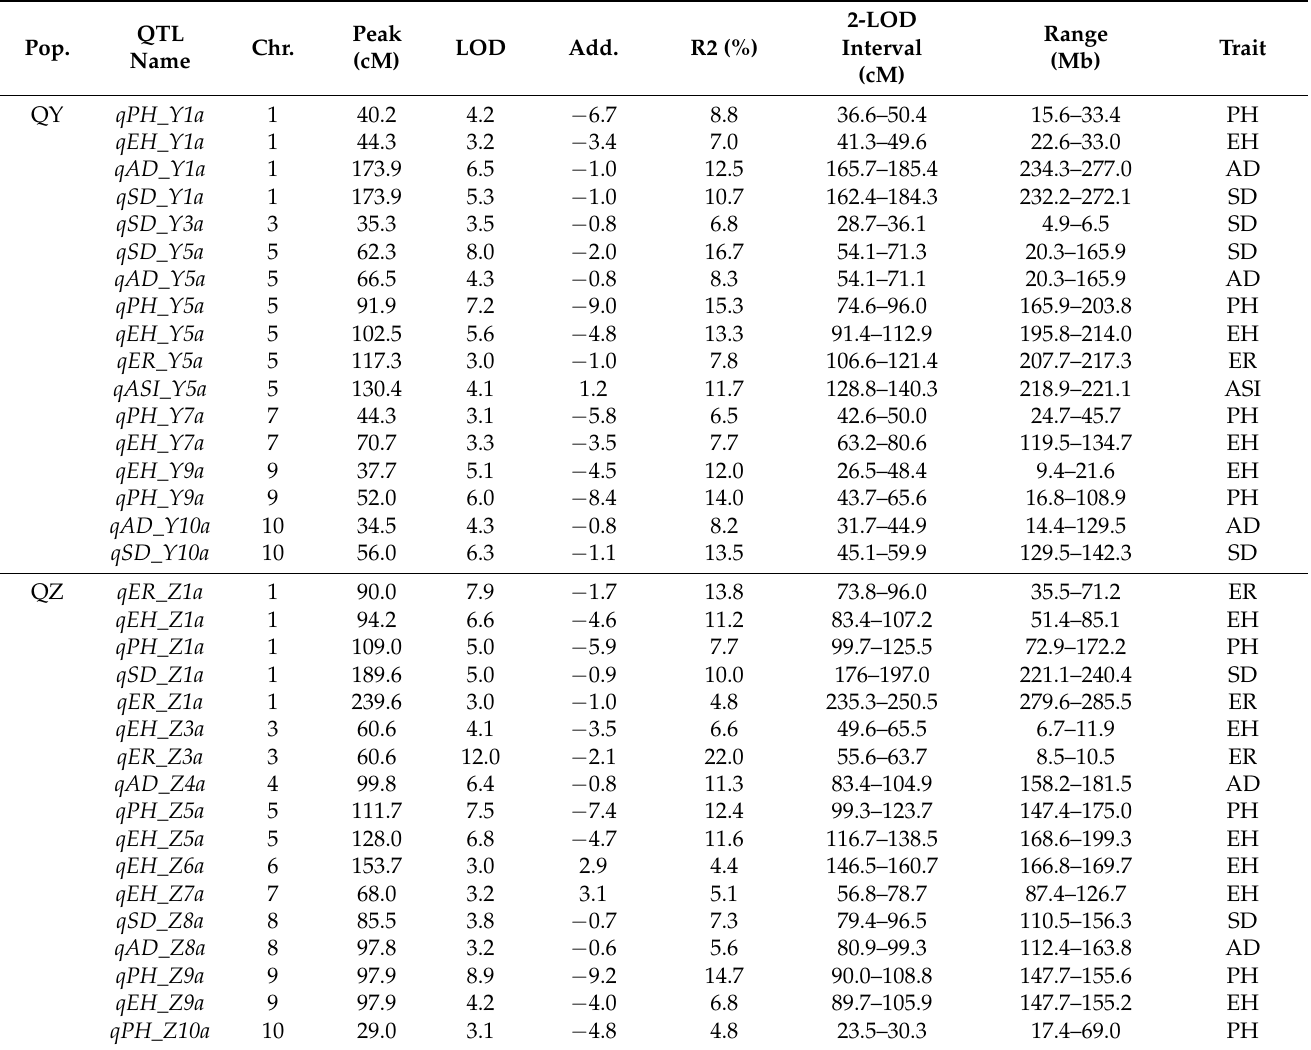
“Pop.” represents the population from which the QTL was detected; “Chr.” is the chromosome; “LOD” is logarithm of odds; “Add.” represents additive effect of QTL; “R2” is phenotypic variation explained by each QTL; “2 LOD interval” represents confidence interval that defines the 2 LOD interval of the QTL; “Range” represents the physical interval of the QTL distributed in the chromosome according to B73